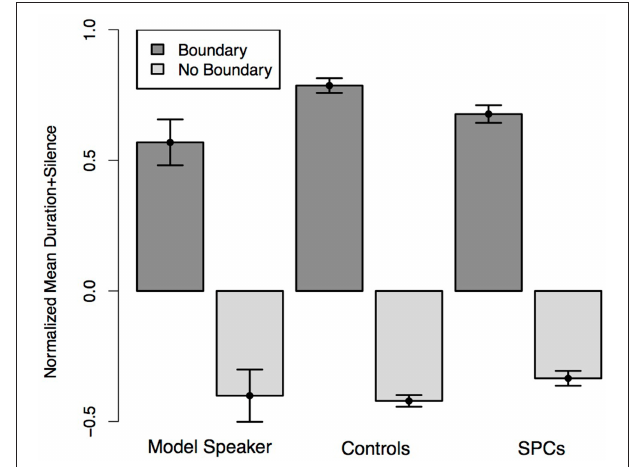
FIGURE 8 | Normalized average duration plus silence of words preceding hypothesized boundary locations and non-boundary locations in the Unambiguous Coordinate Structure sentences as produced by the Model Speaker, Controls, and SPCs. Error bars represent standard